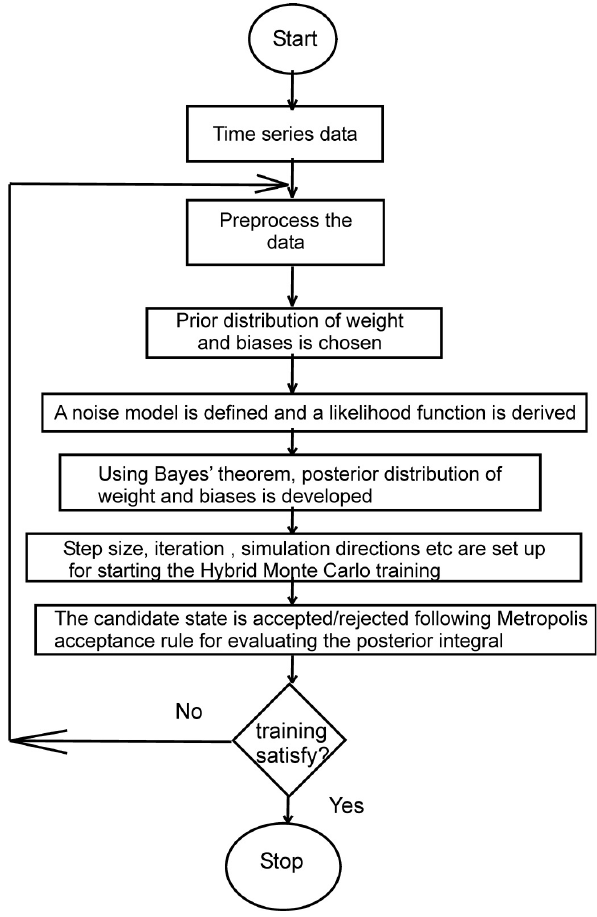
Fig. 3. Flow chart of the general